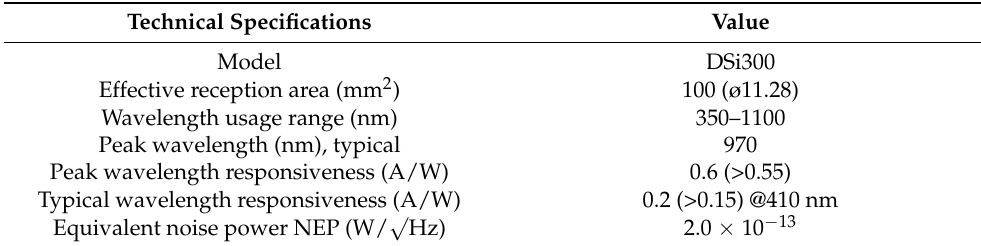
Figure 10. Structure of DSI300 silicon photodetector: ( a ) Main view; ( b ) Top view. Table 1. Parameters of DSI300 Silicon